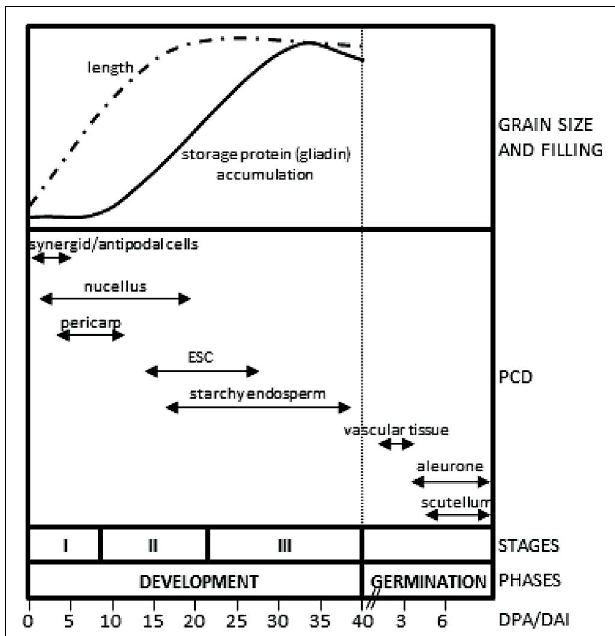
FIGURE 1 | Tissues undergoing PCD in developing and germinating cereal seeds. The upper panel represents the increase in seed length and storage accumulation taking as models the wheat and barley seeds.The lower panel indicates the periods of seed development in which the tissues undergo PCD. Stages of development: I, early development; II, differentiation; III, maturation. ESC, embryo-surrounding cells; DPA, days post anthesis (development); DAI, days after imbibition